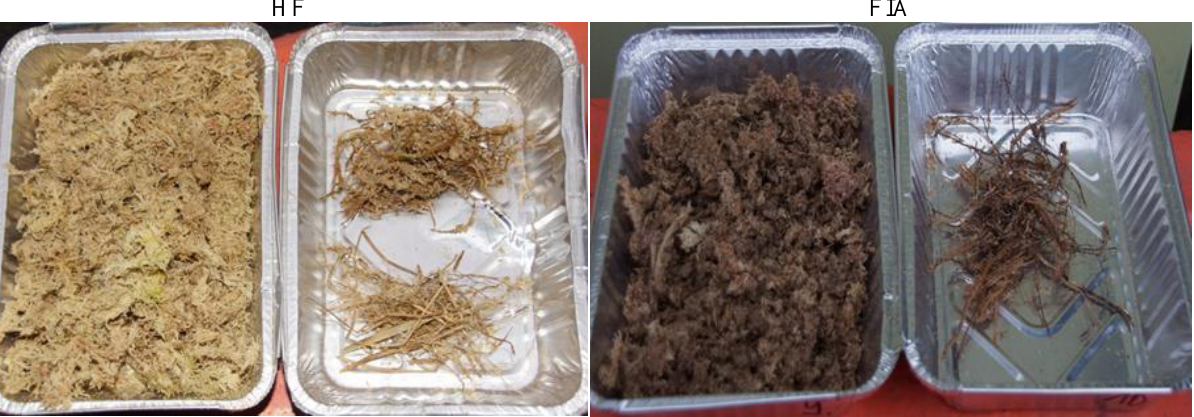
Figure 4. Fractions of Sphagnum moss (left dish) and other plant material (right dish) sorted after drying. Sphagnum from the Hankhausen test site (HF) and Finnish Sphagnum (FIA) (Silke Kumar